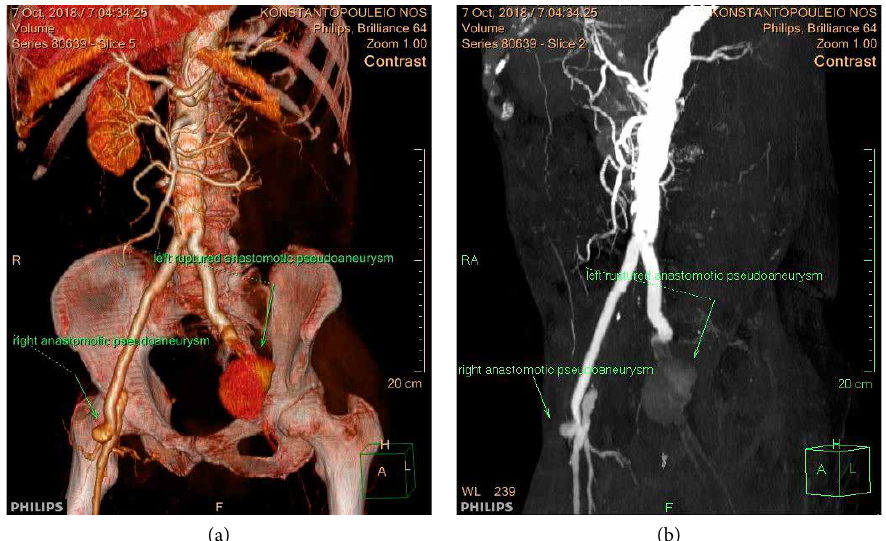
Figure 4: (a) VRT and (b) MIP reconstruction images respectively show both anastomotic pseudoaneurysms (the ruptured left one and the right